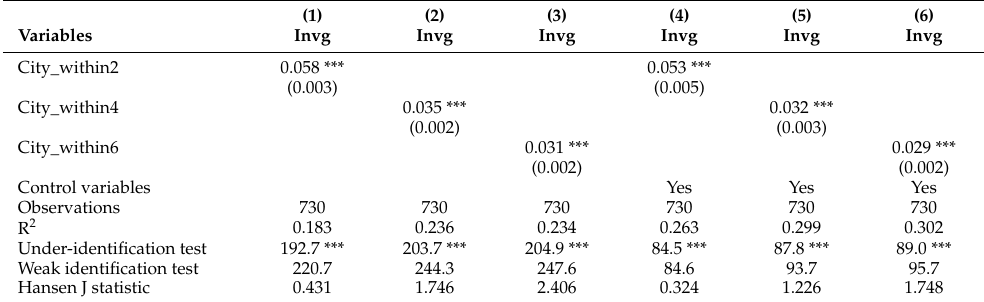
Table 11. Estimated results of the impact of the number of cities accessible within 2, 4, and 6 h by HSR on inventions patent granted without COVID-19